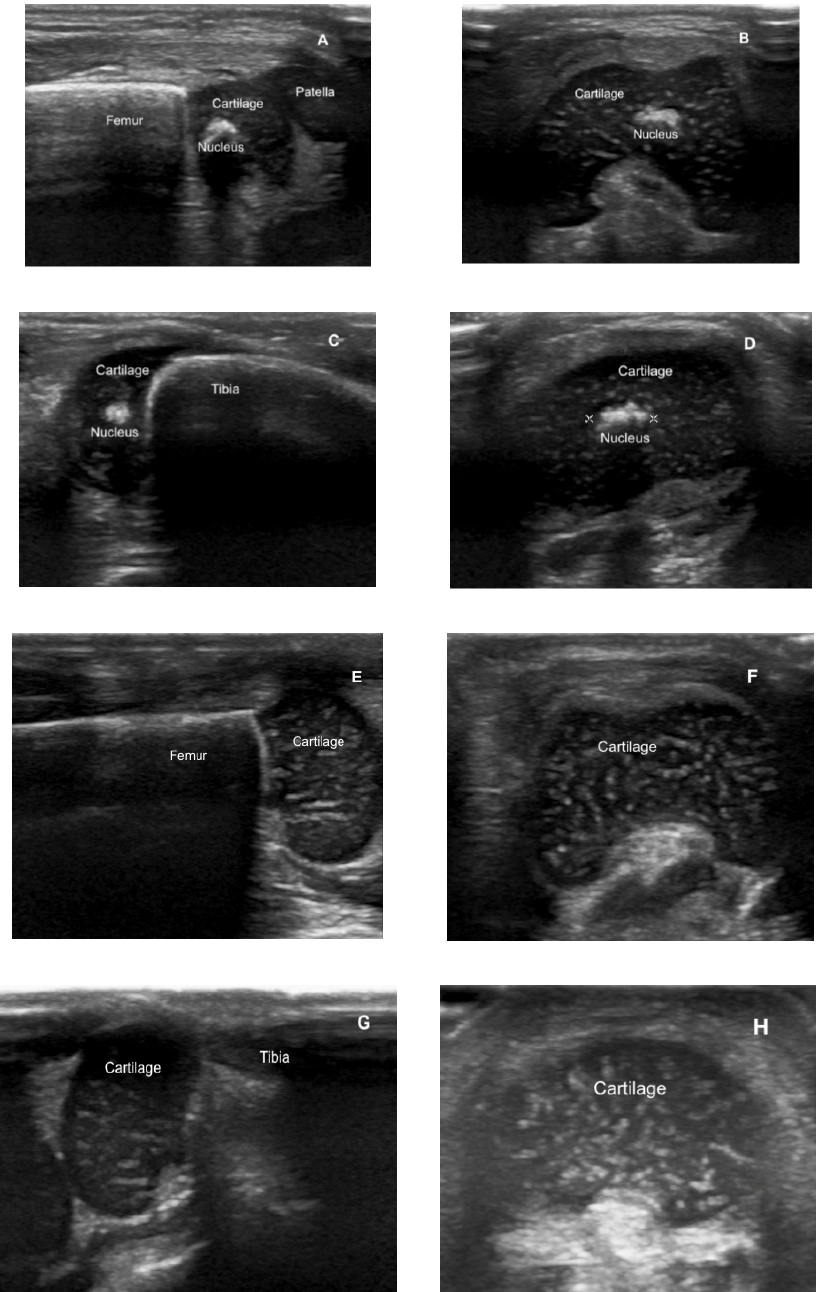
Figure 2. Eco-graphic views of the distal femoral epiphysis (DFE) and the proximal tibial epiphysis (PTE). Pictures A-D show the presence of the DFE nucleus in longitudinal ( A ) and transverse ( B ) views and the PTE nucleus in longitudinal ( C ) and transverse ( D ) views and correspond to a Caucasian 31 + 2 GE male, at 36 postmenstrual weeks. Pictures E-H show the DFE cartilage without nucleus in longitudinal ( E ) and transverse ( F ) views and the PTE cartilage without nucleus in longitudinal ( G ) and transverse ( H ) views.